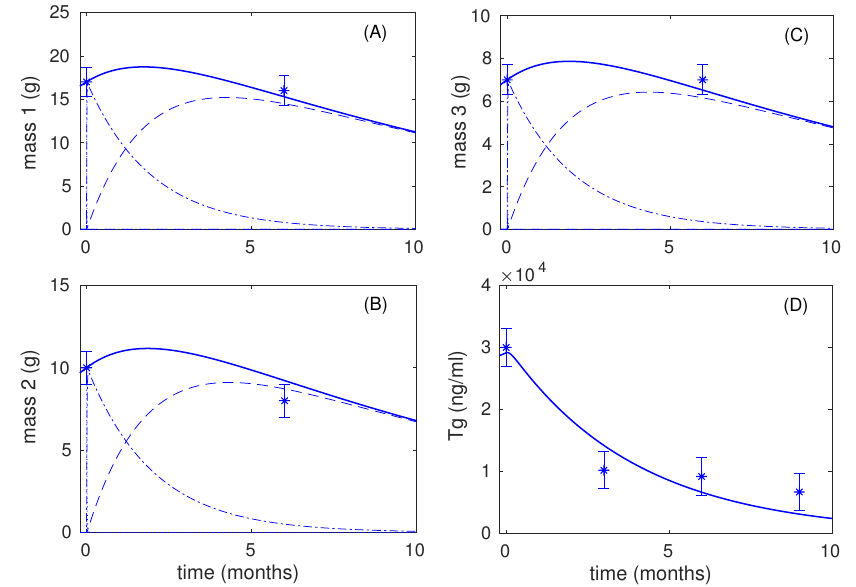
Figure 5. Evolution of three DTC lung metastases with time for a 131 I treatment with two admin- istrations of 7400 MBq each. Experimental measurements, asterisks with standard deviation error bars, and best fits obtained with the model. Panels ( A – C ) show tumor masses corresponding to every lesion: total by a thick solid line; masses corresponding to doomed cells by a dash-dot line; and dead cells by a dashed line. Panel ( D ) shows total thyroglobulin